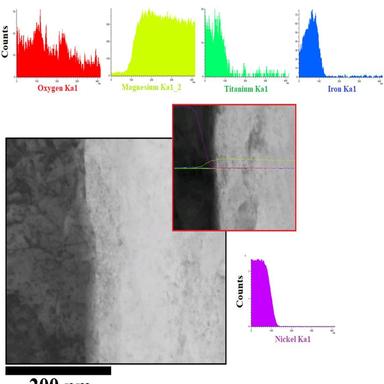
The line-scan EDS analysis results demonstrate the gradual distribution of elements across the Mg/Ni interface.